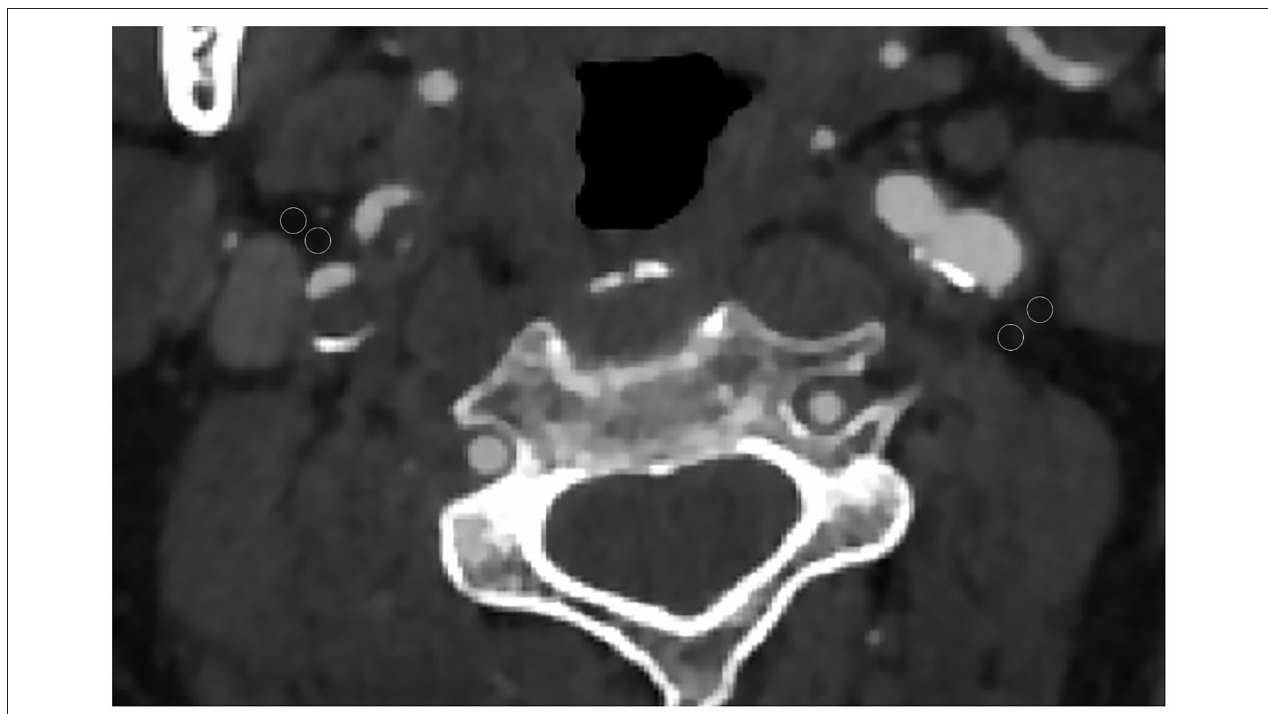
FIGURE 1 | Axial CT angiography image of a 65-year-old male patient. Two regions of interest (ROIs) were placed in the perivascular fat for measured perivascular fat density. In this case, the 2 left ROIs were − 60 and − 68 and the 2 right ROIs were − 62 and −